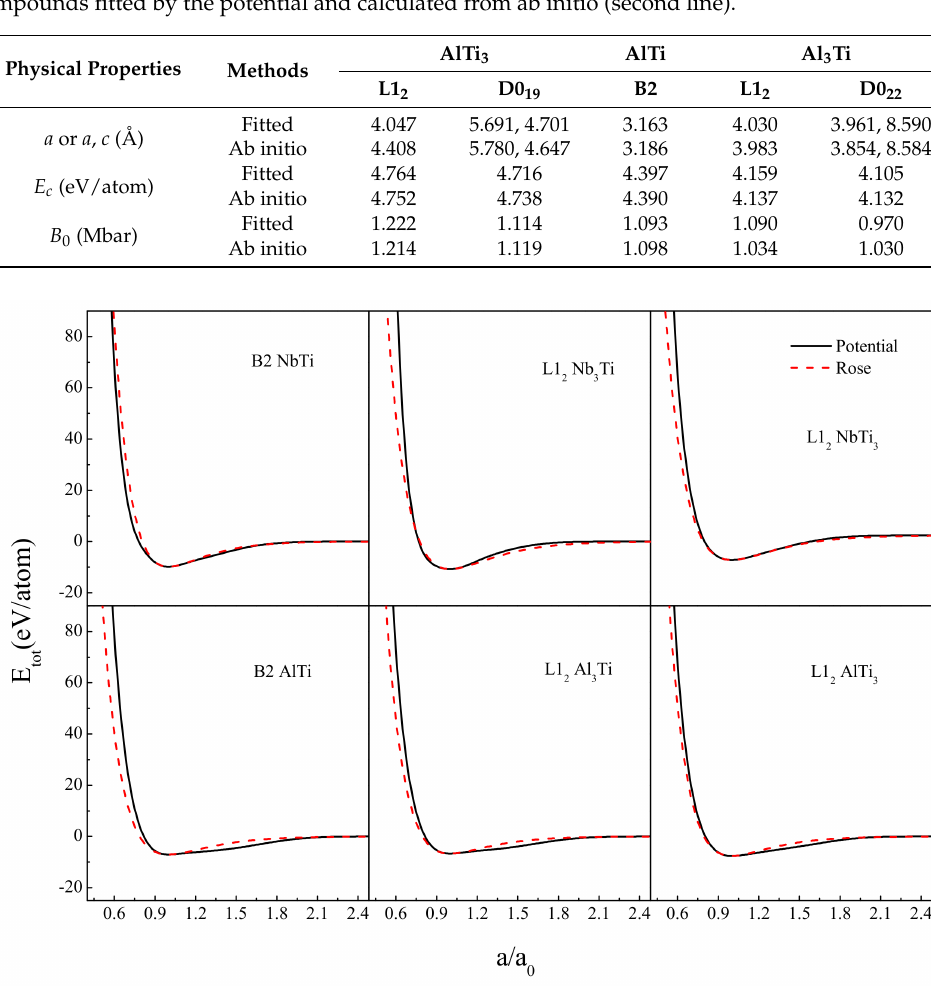
Figure 1. Potential energies (solid line) as a function of lattice constant compared with the Rose equation (dash